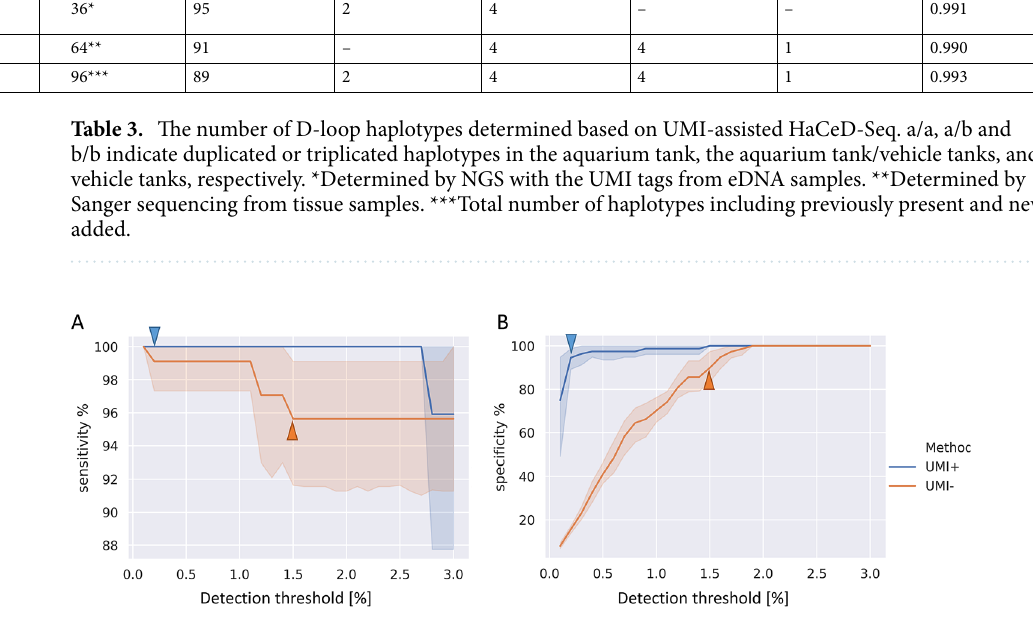
Figure 3. Differences in sensitivity and specificity with and without the UMI tags. ( A ) The relationship between the detection threshold and sensitivity changed depending on whether the UMI tags were used and depending on the detection threshold for the cluster size. Here, the sensitivity is the percentage of correct haplotypes among the total haplotypes observed. ( B ) The relationship between the detection threshold and specificity. Here, the specificity is the percentage of correct haplotypes compared to all the detected haplotypes. The horizontal axis shows the detection threshold, which is the size of the cluster when the most abundant haplotype is set to 100%. A threshold that was as low as possible without decreasing specificity was selected. The threshold finally adopted by HaCeD-Seq with the UMI tags (0.2%) is indicated by a blue triangle; the threshold adopted without the UMI tags (1.5%) is indicated by an orange